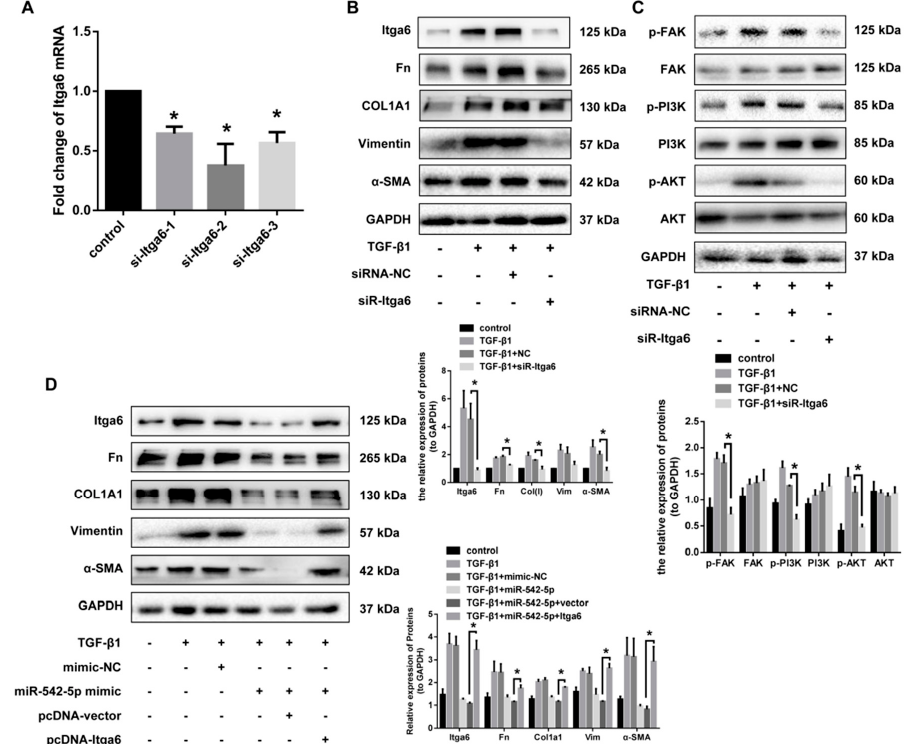
Figure 7. miR-542-5p suppressed fibroblast differentiation by targeting Itga6 through the FAK signaling pathway. ( A ) Knockdown efficiency of three siRNAs towards Itga6. ( B ) The protein level of Itga6 and other fibrosis markers in NIH-3T3 cells transfected with siR-Itga6. Except for the inhibition of Itga6 expression, siR-Itga6 restored the level of fibrosis markers (fibronectin, collagen I, α - SMA and vimentin), which were previously increased by TGF- β 1. * p < 0.05 versus the TGF- β 1 + siRNA-NC group. ( C ) Western blot analysis of protein levels of the phosphorylated or non-phosphorylated FAK/PI3K/AKT signaling pathway, * p < 0.05 was considered to be statistically significant. ( D ) Western blot analysis of fibrosis markers (fibronectin, collagen I, α - SMA and vimentin) in NIH-3T3 cells co-treated with miR-542-5p mimic and pcDNA-Itga6. * p < 0.05 versus TGF- β 1 plus the miR-542-5p mimic and the pcDNA vector